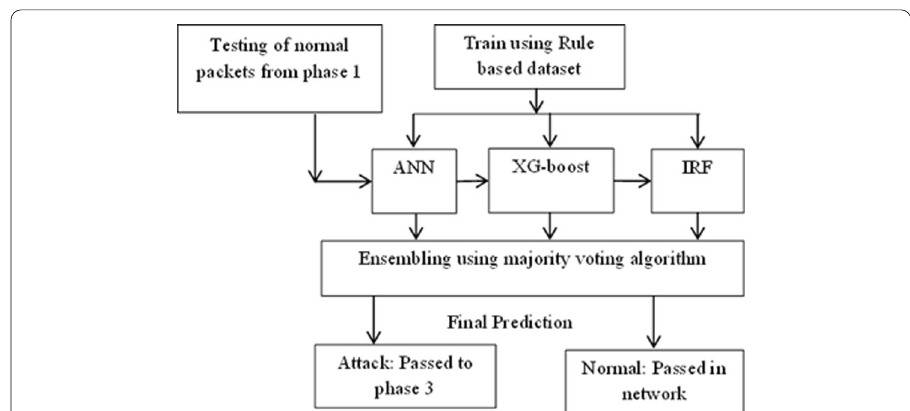
Fig. 4 BC-HyIDS phase 2: anomaly based detection architecture. Detailed architecture of phase 2 that is anomaly based detection for system. Input will be taken from phase 1, the packets which are considered as normal. Rule dataset is used to train classifiers. Rule based dataset is generated using genetic algorithm.